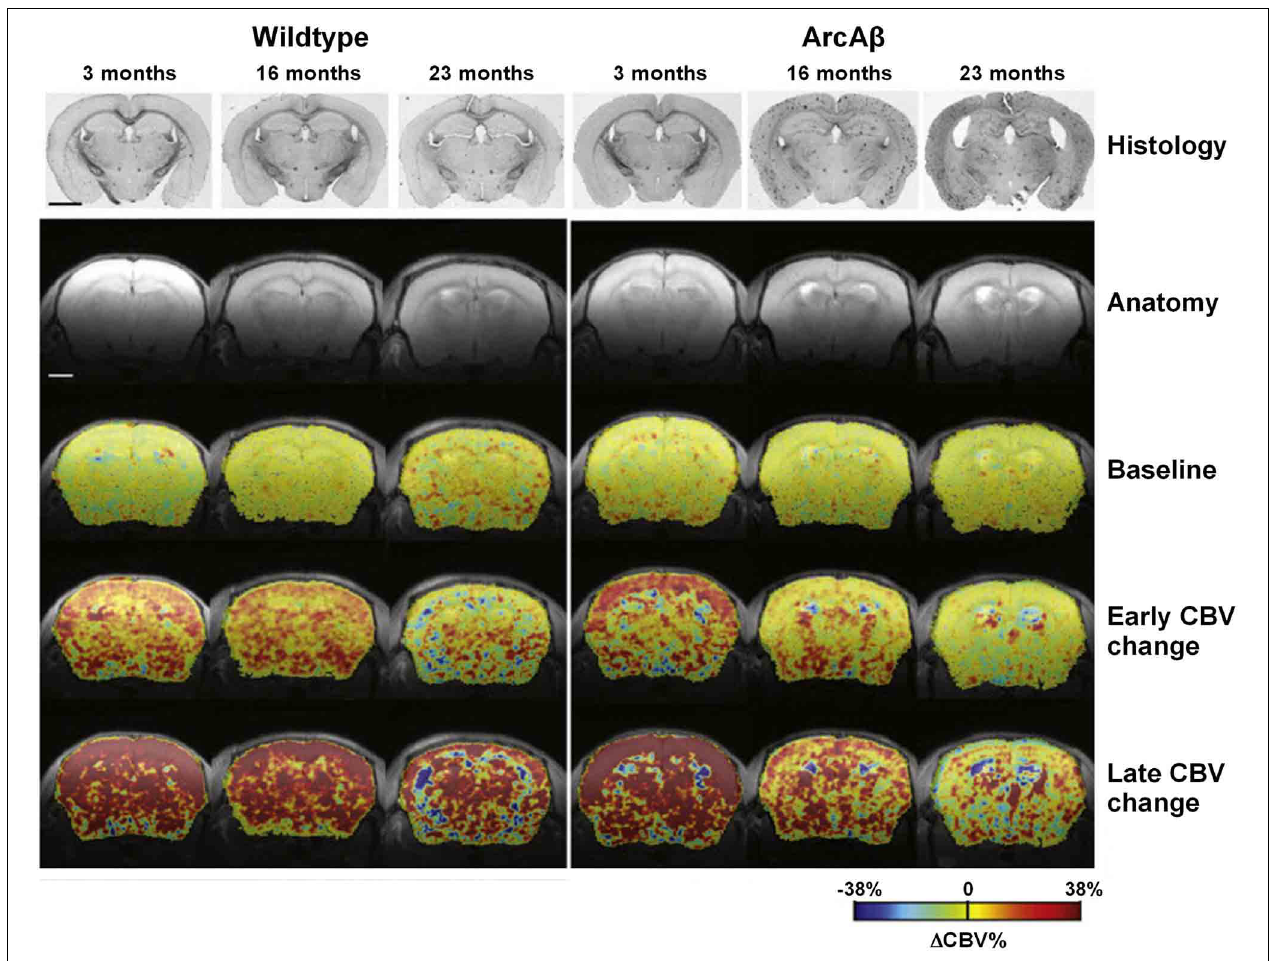
FIGURE 6 | Vascular response to acetazolamide decreased as a function of age in the arcA β mouse model of cerebral amyloidosis, exemplified in color-coded MRI-derived CBV maps. Images for a representative age-matched wild-type control littermate and an arcA β mouse of each age group. Histological sections stained for A β amyloid deposition as well as anatomical MR reference images are displayed in the two top rows. Histology reveals A β deposition in 16- and 23-month-old but not 3-month-old arcA β mice, while none of the wild-type animals displayed any amyloid pathology. The color-coded CBV maps